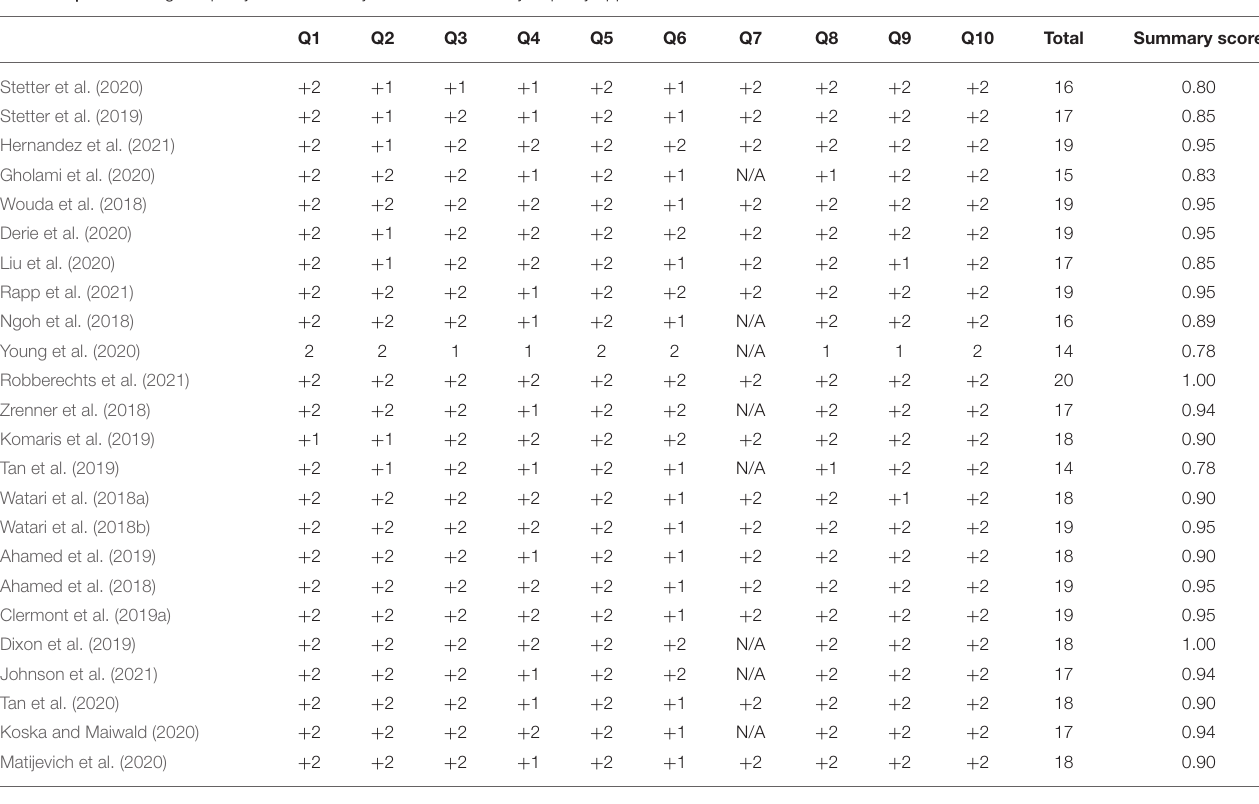
TABLE 2 | Methodological quality assessment by the modified QualSyst quality appraisal